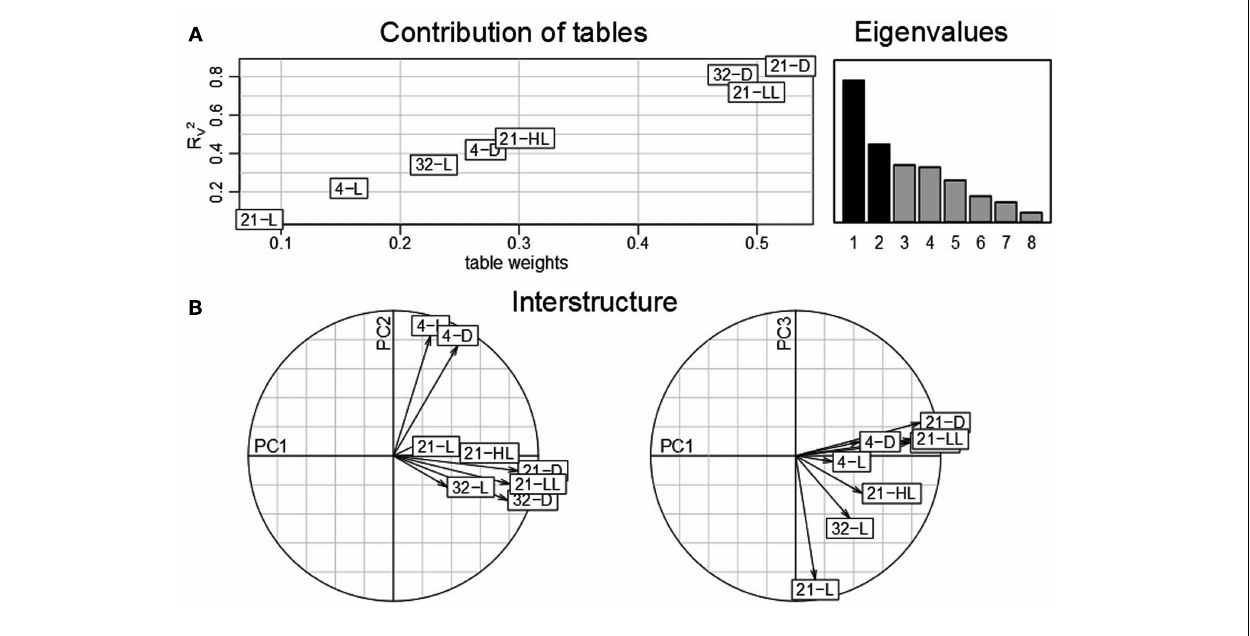
(B) The interstructure is the projection of the individual condition on the principal components (PC1 and PC2 on the left, PC1 and PC3 on the right) allowing characterization of the effects governing the separation of